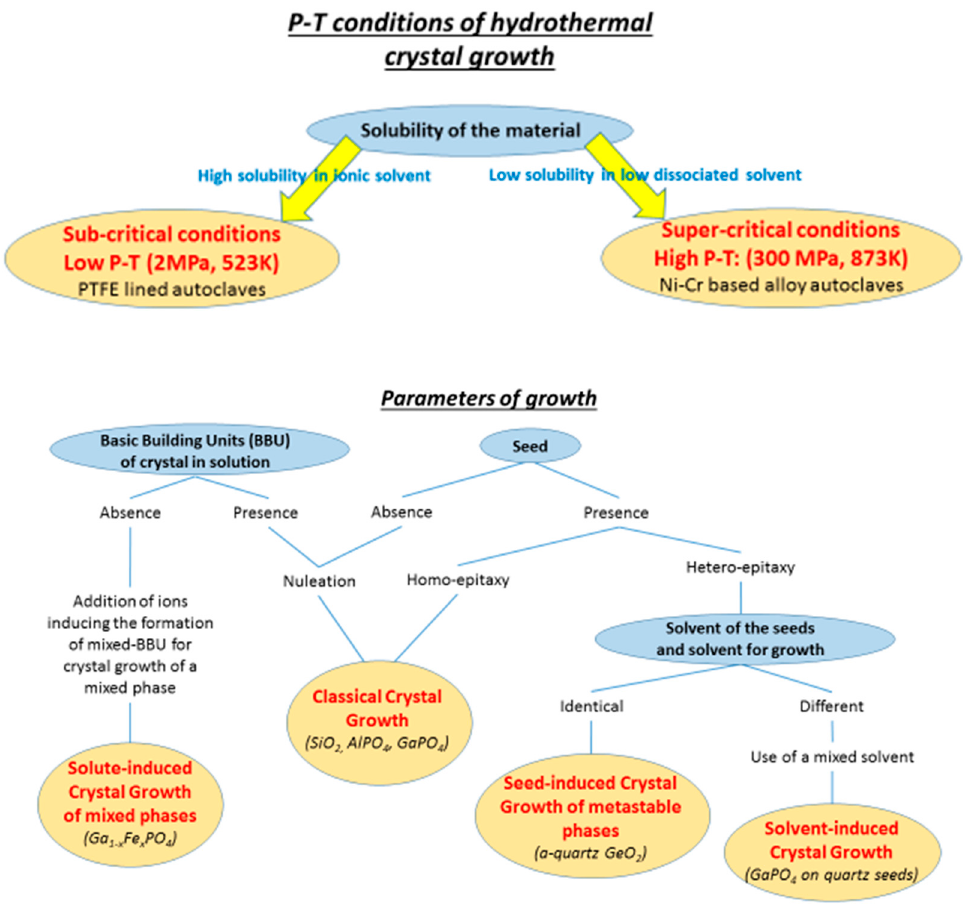
Figure 2. Schematic summary of different parameters governing the hydrothermal crystal growth of the α -quartz type materials.